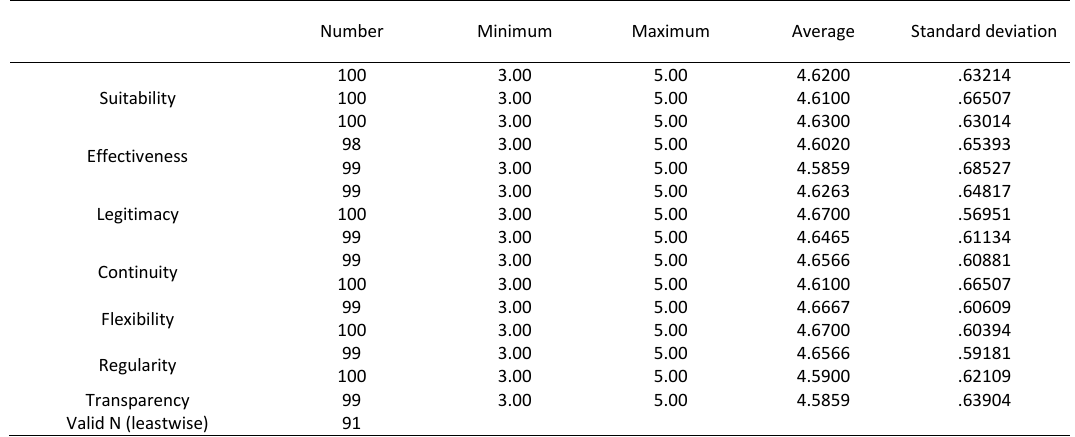
Table 9: Mean and standard deviation of each of the criteria and sub-criteria of the overall evaluation of the research conceptual mode